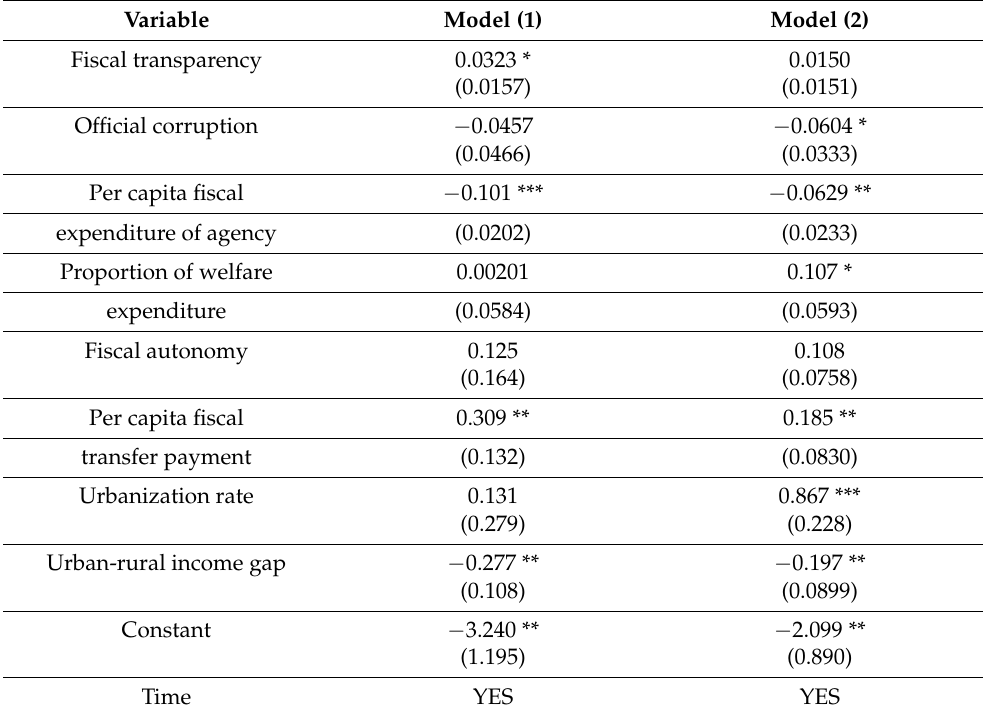
Table 5. The effect of fiscal transparency on the quality of public services in 12 coastal provinces and cities of